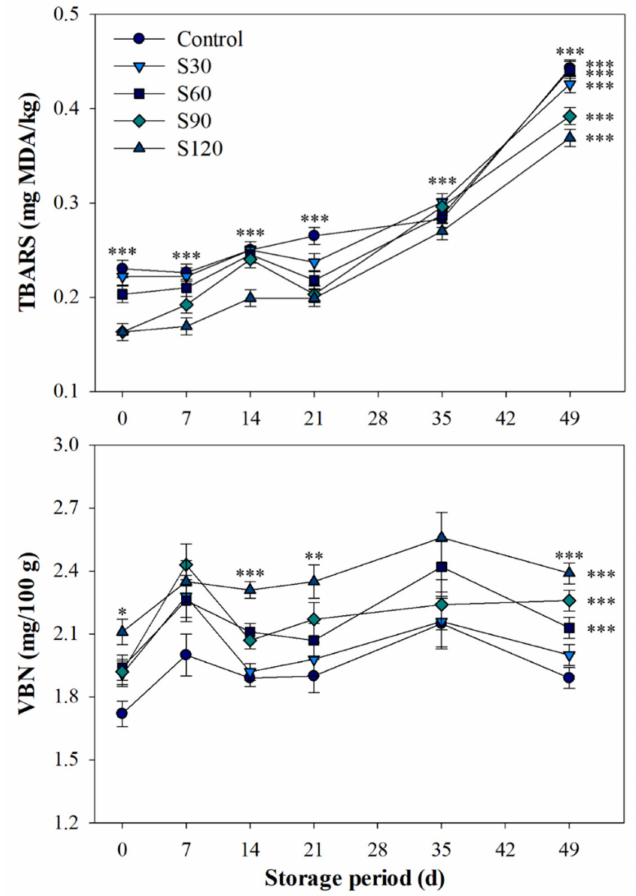
Figure 1. E ff ects of searing process on 2-thiobarbituric acid reactive substance (TBARS) and volatile basic nitrogen (VBN) values of sous-vide cooked pork patties during storage. Bars indicate standard errors of means. Level of significance: * p < 0.05; ** p < 0.01; *** p <